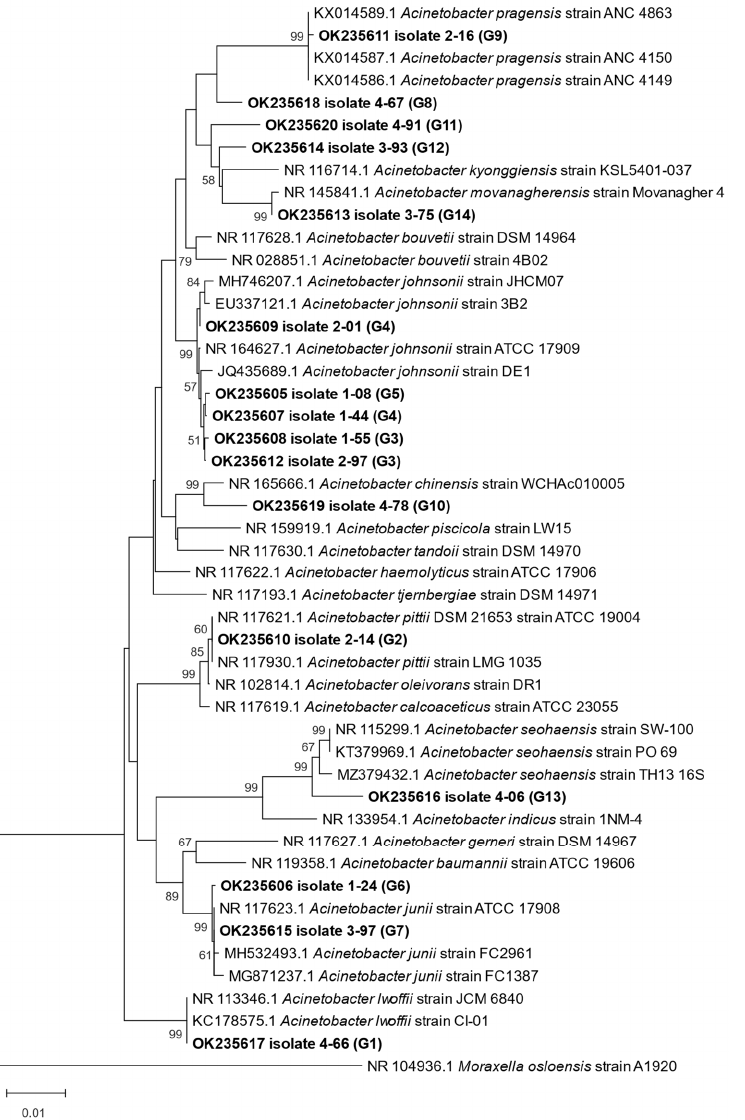
Figure 4. Phylogenetic placement of representative Acinetobacter strains (OK235605-OK235620) from the wastewater treatment plant within the genus Acinetobacter . G1–G14—genotypes obtained based on digestion of 16S rRNA gene using three different restriction enzymes AluI, MspI and RsaI. Phylogenetic tree was constructed using neighbor-joining method with 1000 bootstrap replications. The evolutionary distances were computed using Kimura 2-parameter model.